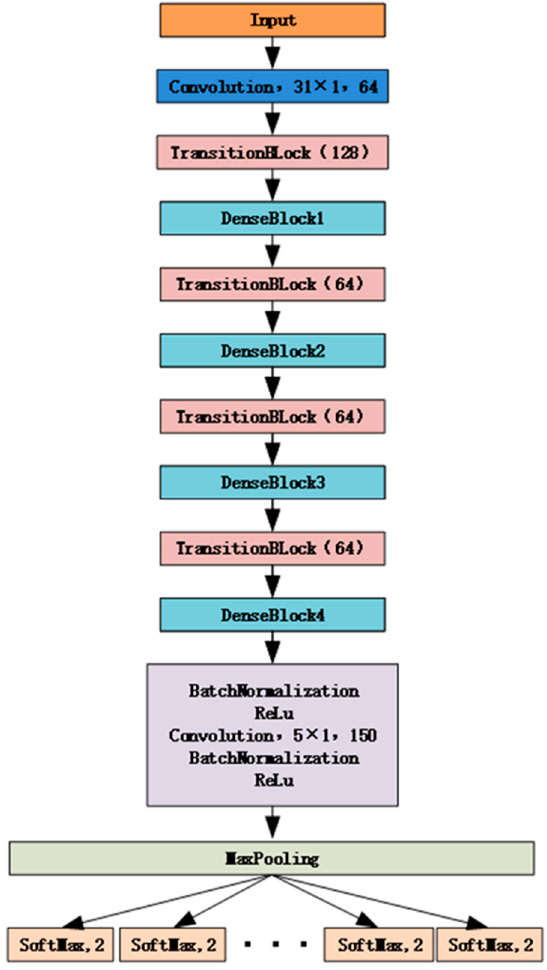
Figure 5. Network structure of intelligent receiver.